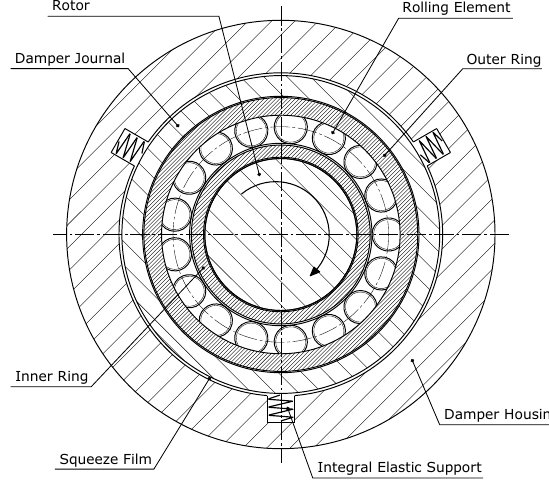
Figure 1. Schematic overview of an integral spring squeeze film